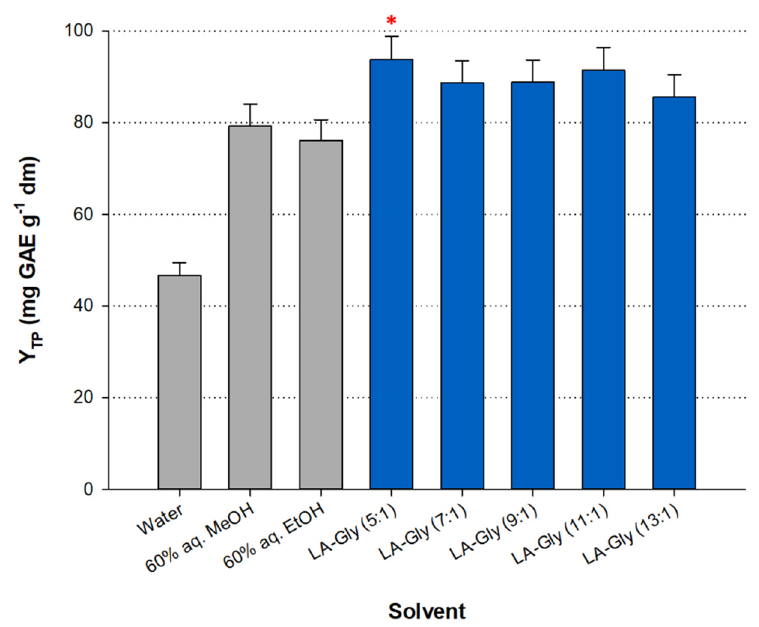
Figure 1. R D/A screening and comparison with control solvents. DES were 70% (w / v) aqueous mixtures. Figure 1. R (cid:2923)(cid:2925)(cid:2922)(cid:2888)/(cid:2885) screening and comparison with control solvents. DES were 70% (w/v) aqueous mol Extractions were performed under stirring at 500 rpm, for 150 min., at 50 ◦ C. * —the highest YTP mixtures. Extractions were performed under stirring at 500 rpm, for 150 min., at 50 °C. * —the highest ( p < YTP ( p < 0.05).